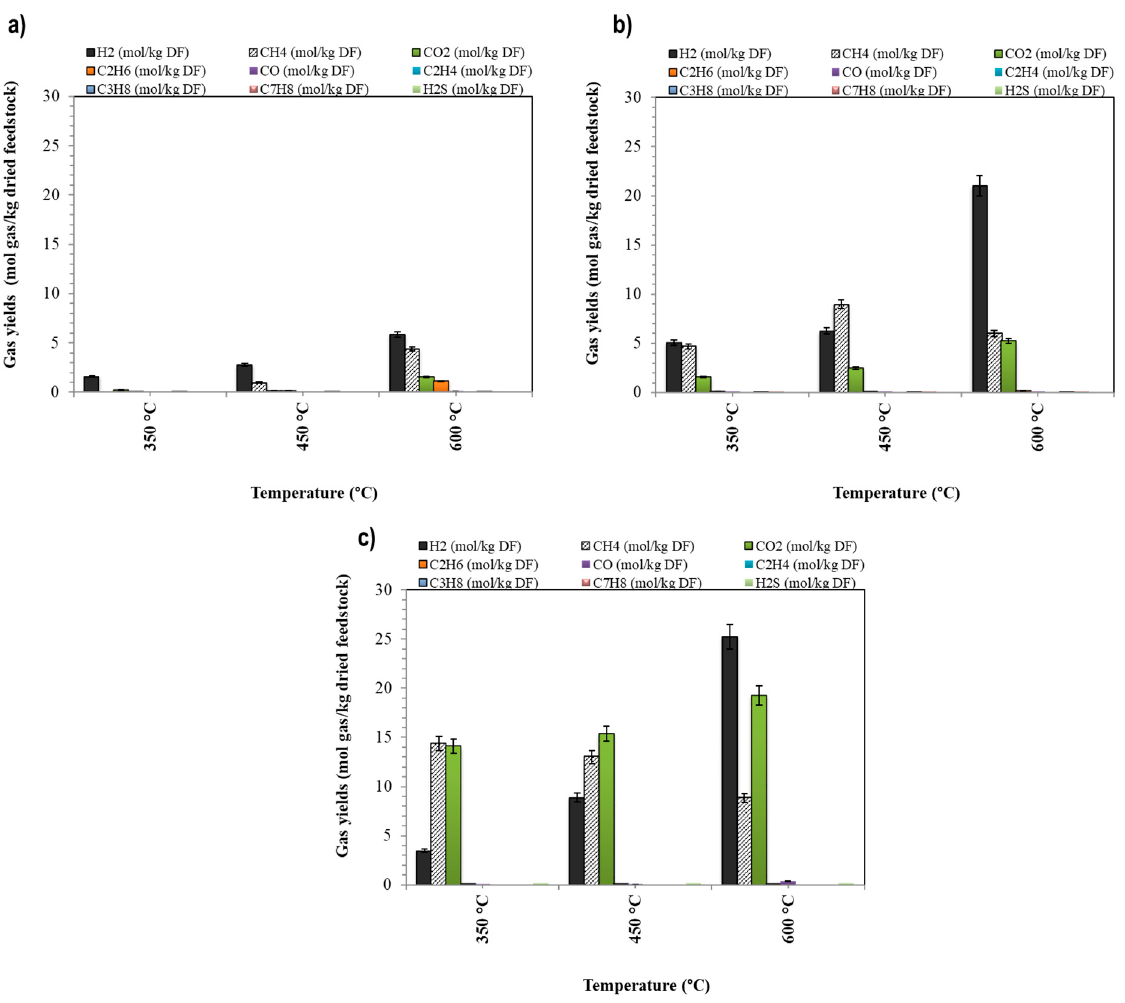
Figure 5. Gas yields: ( a ) non-catalytic experiments; ( b ) catalytic experiments; ( c ) thermodynamic equilibrium calculations.